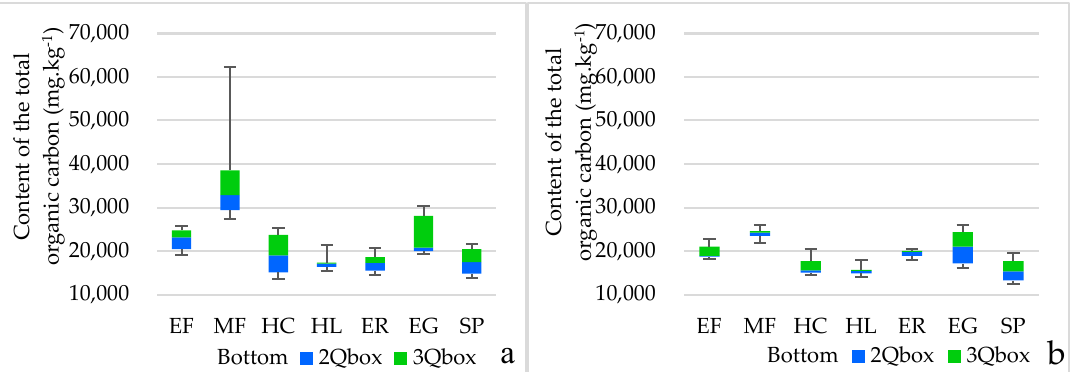
Figure 4. Differences (mg.kg − 1 ) in total organic carbon of soils from a depth of ( a ) 0.0–0.1 m and ( b ) 0.0–0.3 m. EF: Eutric Fluvisol; MF: Mollic Fluvisol; HC: Haplic Chernozem; HL: Haplic Luvisol; ER: Eutric Regosol; EG: Eutric Gleysol; SP: Stagnic Planosol. Error bars represent maximum and minimum values.